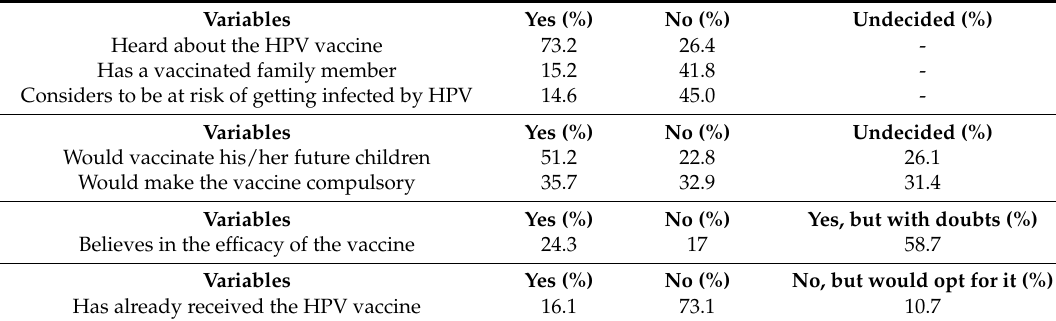
Table 8. Knowledge about/attitudes toward HPV vaccination.